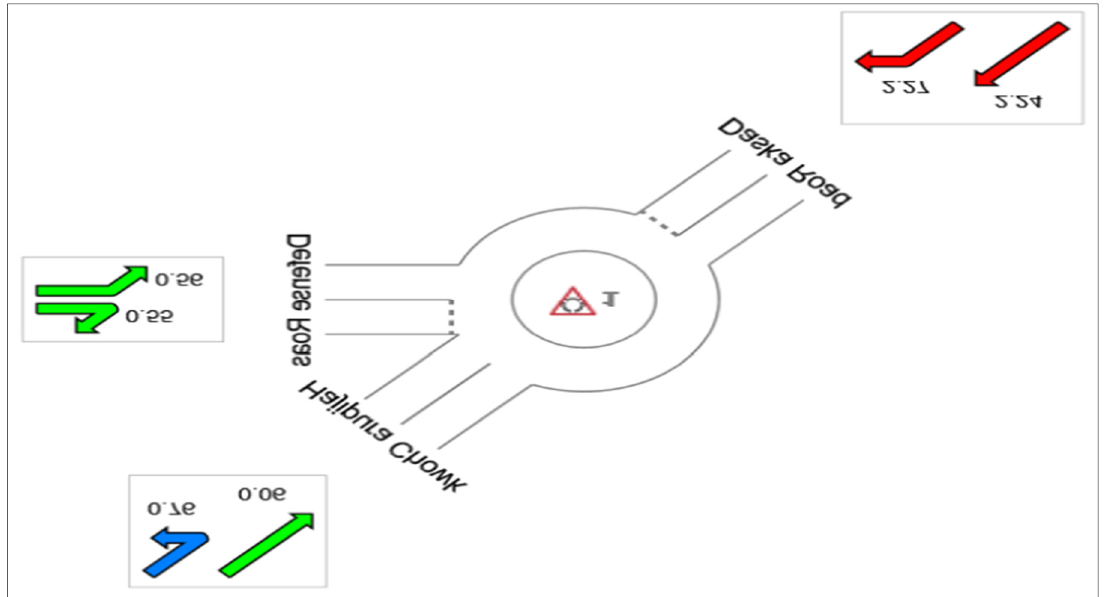
Fig. 7: Degree of Saturation in Modified Condition at Daska Intersection